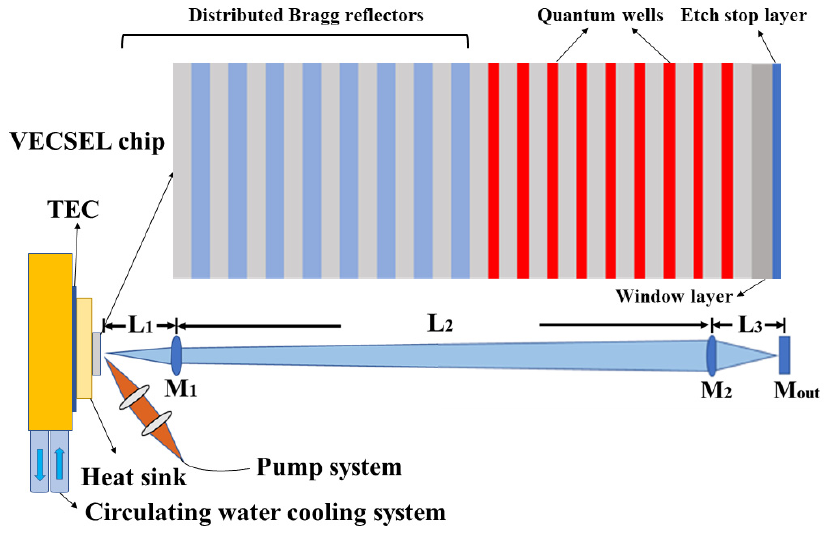
Figure 1. Schematic of the working principle in the long-cavity VECSEL.